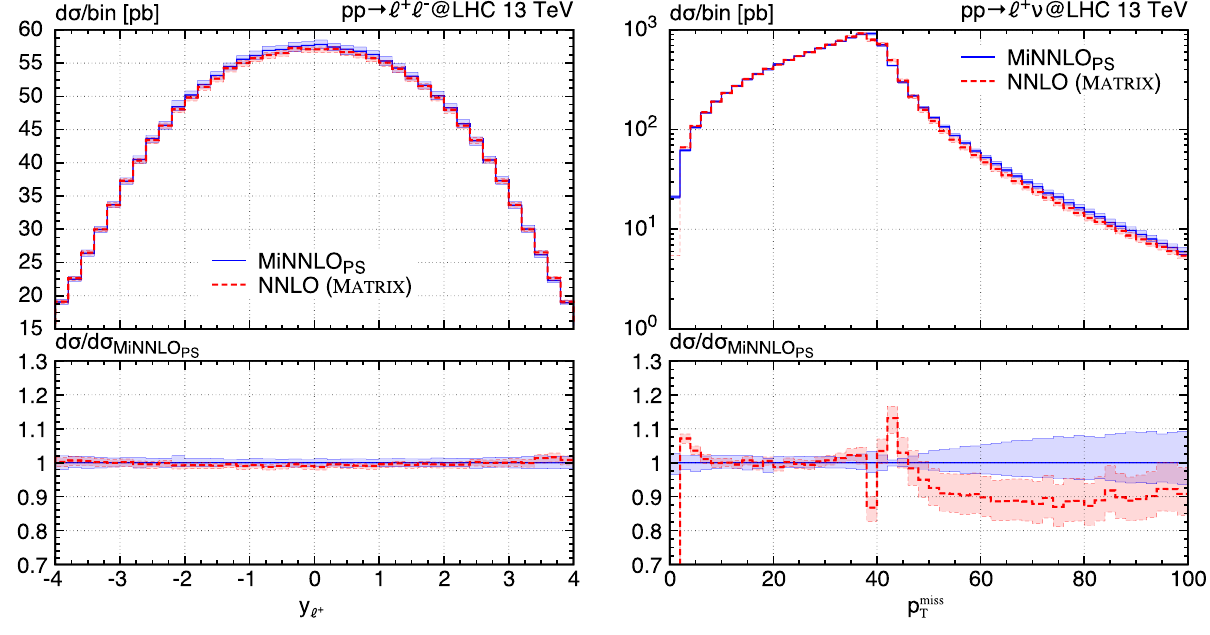
Fig. 5 Rapidity distribution of the charged lepton (left) and missing transverse momentum (right) in charged-current Drell Yan production. The lower panel shows the ratio to the MiNNLO PS